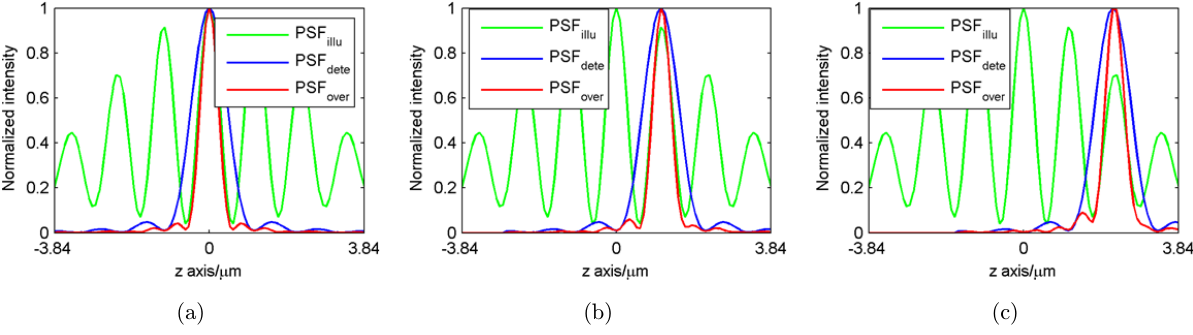
Fig. 11. The overall point spread function of light sheets in xz plane.